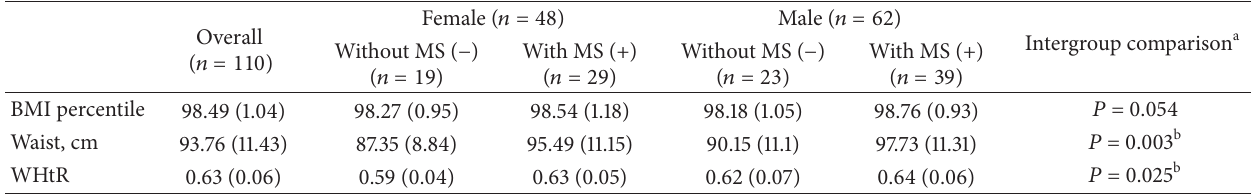
Intergroup comparison a Without MS ( −